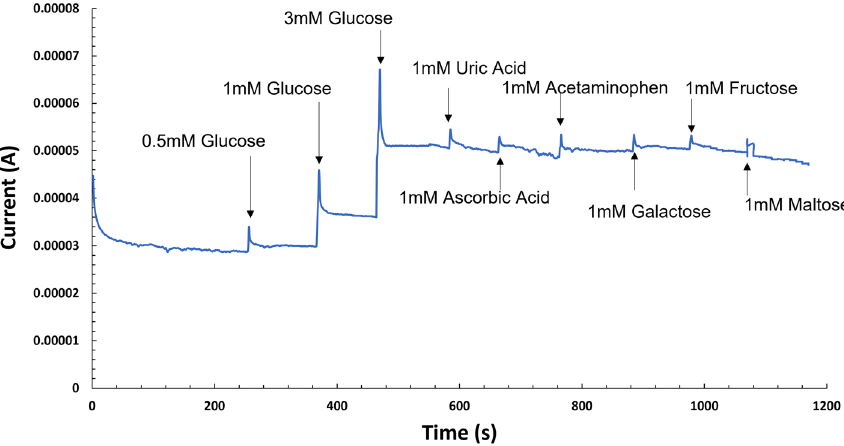
Figure 5. Current ( i ) response profile of interfering analytes at co–Pt anode upon the addition of 0.5 mM, 1 mM, and 3 mM glucose and 1 mM of interfering analytes at applied potential: − 0.1 V in 0.1 M PBS pH